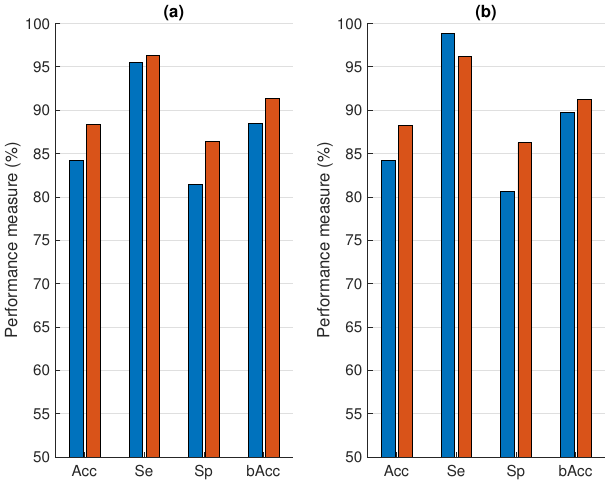
Figure 6. Comparison of the performance on the CC dataset without (blue bars) and with (red bars) transfer learning. ( a ) Trained on the PSG dataset. ( b ) Trained on the HH